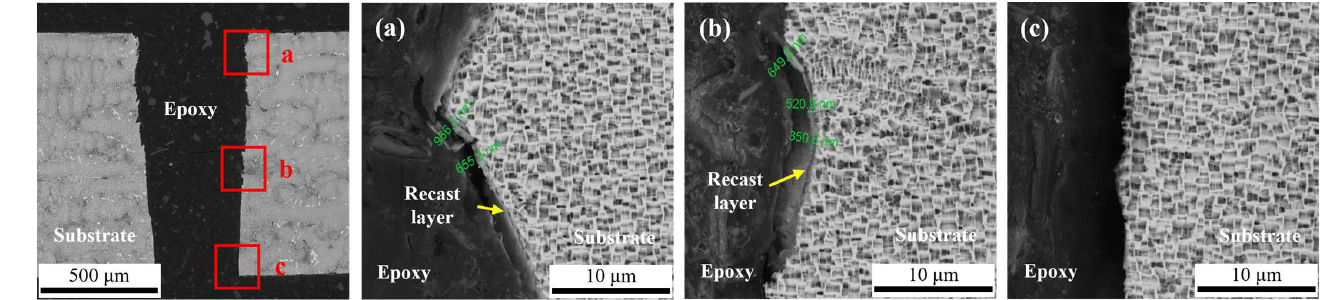
Figure 18. SEM morphologies of the hole machined by CWALSM. ( a ) Hole entrance; ( b ) Hole middle; ( c ) Hole exit.